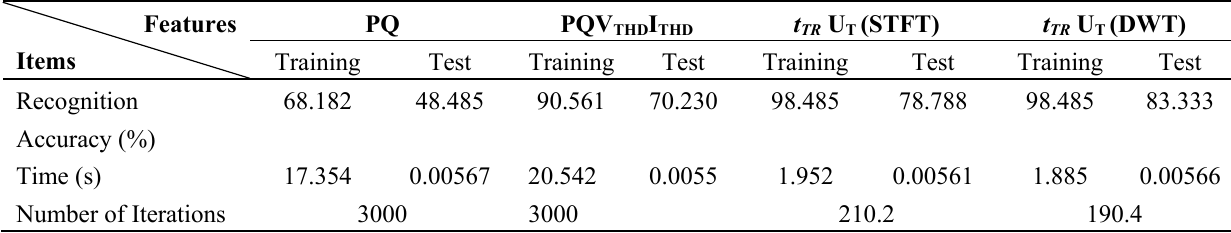
Table 4. The results of load identification in Case Study